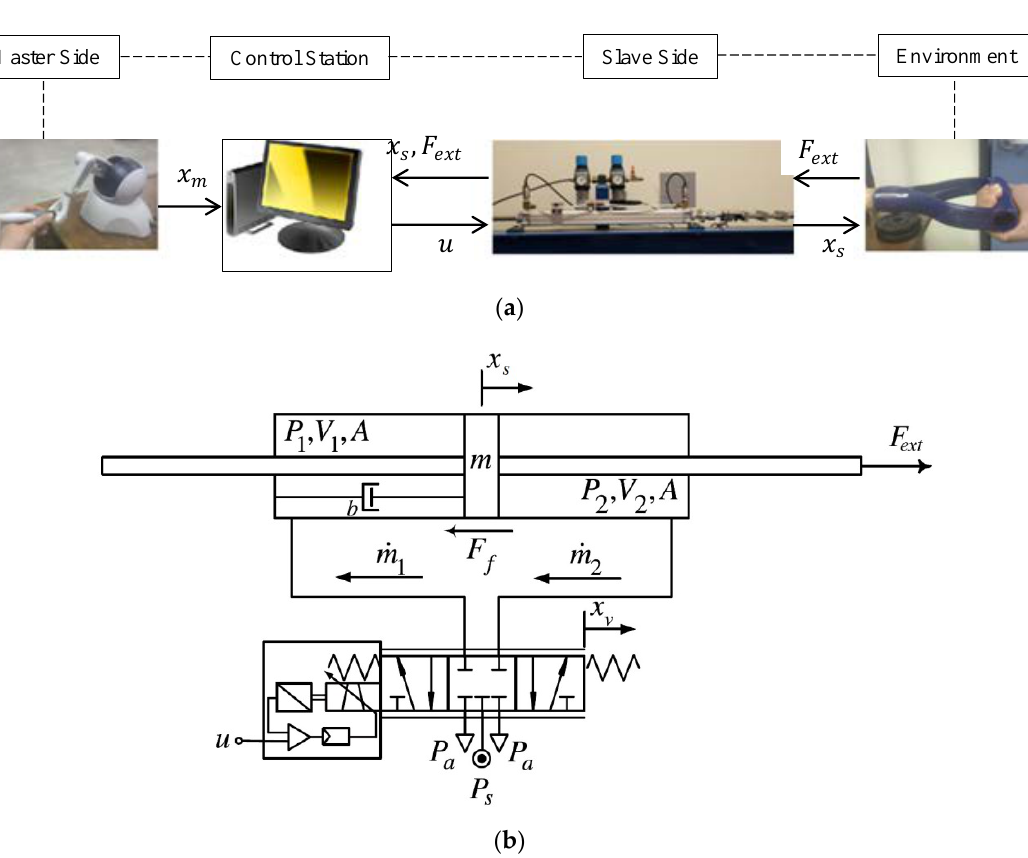
Figure 1. ( a ) Test setup of unilateral admittance-controlled of the pneumatic actuator; ( b ) schematic diagram of pneumatic system [21].